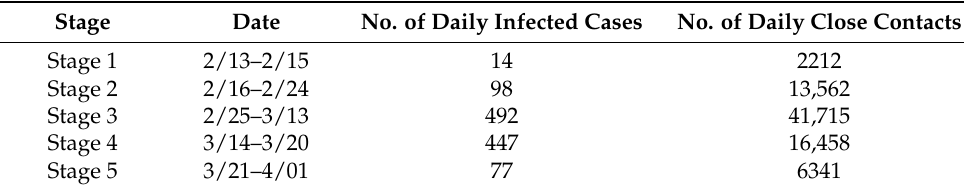
Table 1. The number of daily close contacts and infected cases by different epidemic stages during the Omicron epidemic in Shenzhen, China, in the spring of 2022.